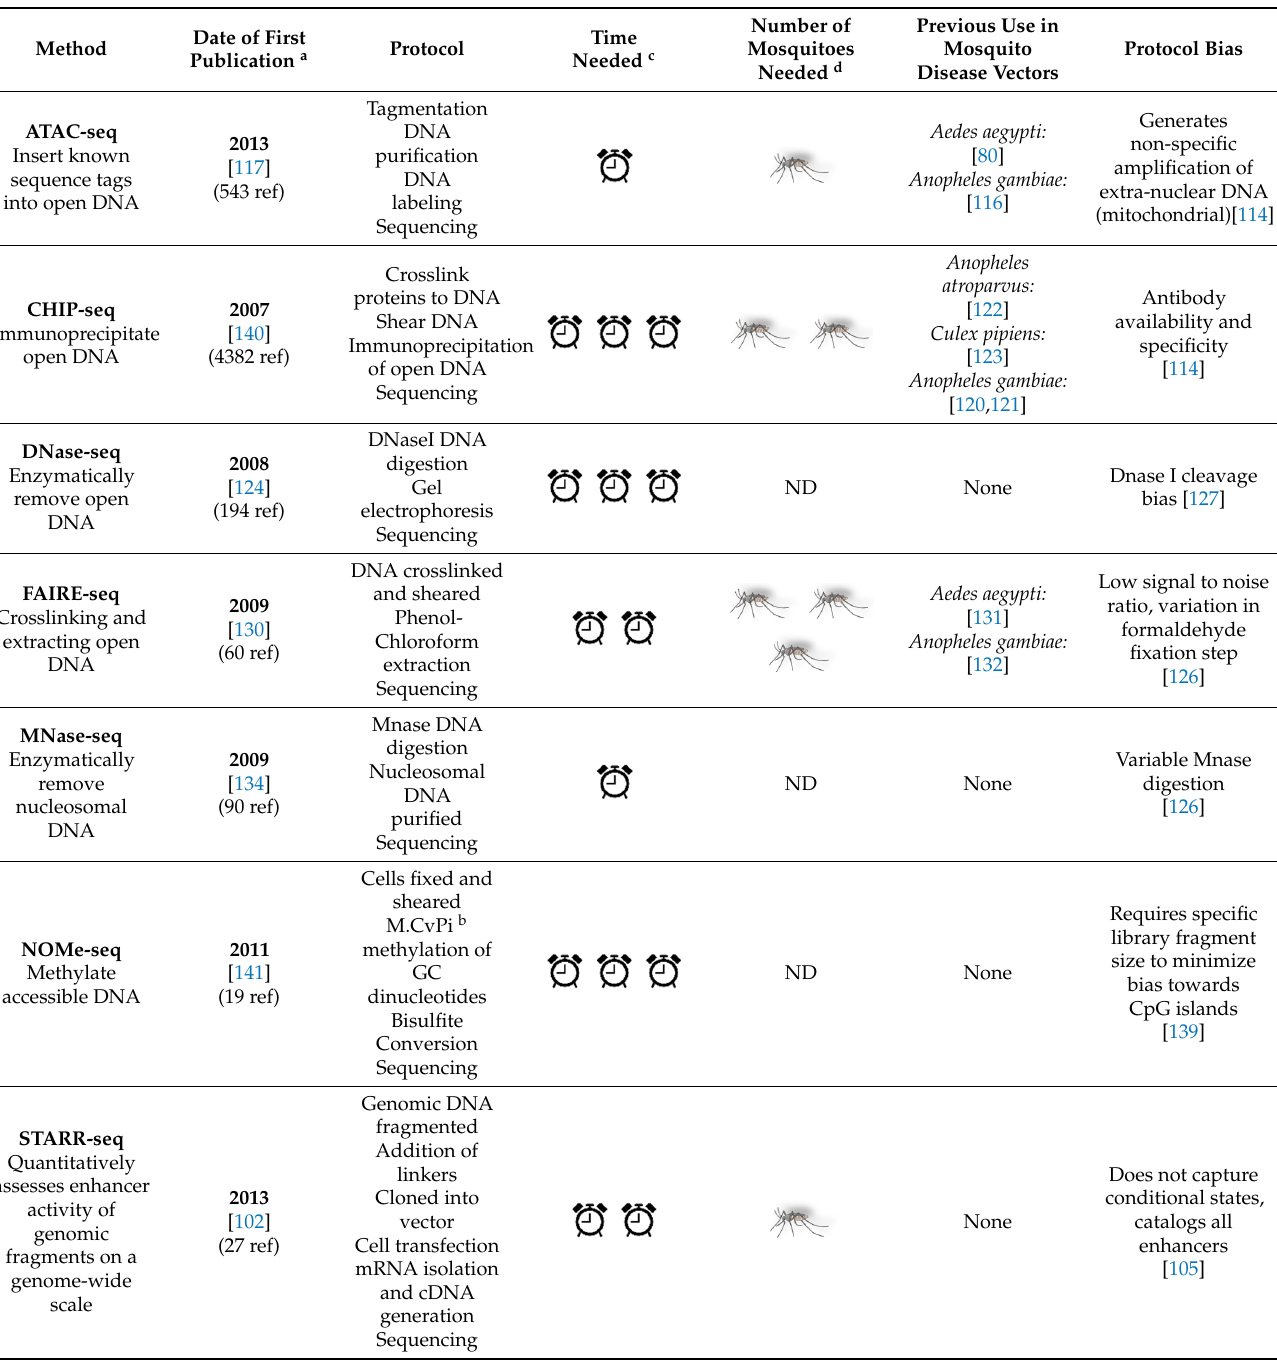
Table 1. Direct and indirect methods for enhancers/cis-regulatory element discovery.